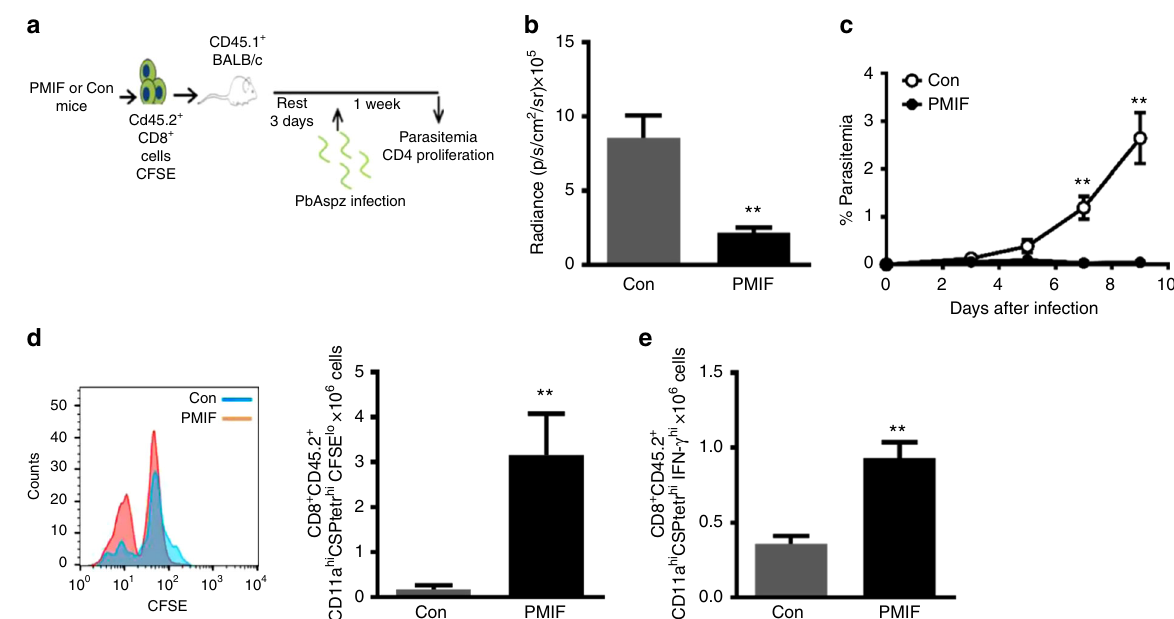
Fig. 8 Adoptively transferred liver CD8 T cells from PMIF-immunized mice confer protection to homologous sporozoite challenge. a BALB/cJ mice immunized with replicons encoding Con RNA or PMIF RNA were infected with 2000 Pb AWT sporozoites and cured by 6 days of chloroquine treatment (days 7 – 12). Four weeks later, the mice were reinfected with 2000 Pb AWT sporozoites and T cells from liver isolated 7 days after infection, incubated with chloroquine to eliminate residual blood-stage parasites, and labeled with CFSE. Puri fi ed CD45.2 + CD8 T cells (2 × 10 7 ) then were transferred into naïve congenic CD45.1 BALB/cJ hosts and the mice infected 3 days later with 2000 Pb AWT sporozoites. b Luminescence values of infected mice and c parasitemia in mice adoptively transferred with liver CD8 T cells from Con RNA (white circle) or PMIF RNA (black circle) immunized mice. Results are from two separate experiments. Bars represent the mean of 6 mice ± SD ** p < 0.01 by two-way ANOVA. d Representative CFSE dilution histogram of adoptively transferred (CD45.2) CD8 T cells from Con RNA or PMIF RNA immunized donors and enumeration of recovered CD45.2 CD8 T cells. e Number of proliferating CD45.2 CD8 T cells (CFSE lo ) producing IFN- γ after stimulation ex vivo with CSP peptide in the presence of Brefeldin A. Results are from two separate experiments. Bars represent the mean of 6 mice ± SD;** p < 0.01 by two-tailed Mann – Whitney test, error bars denote precursors expressing Th1-type molecules such as T-bet and